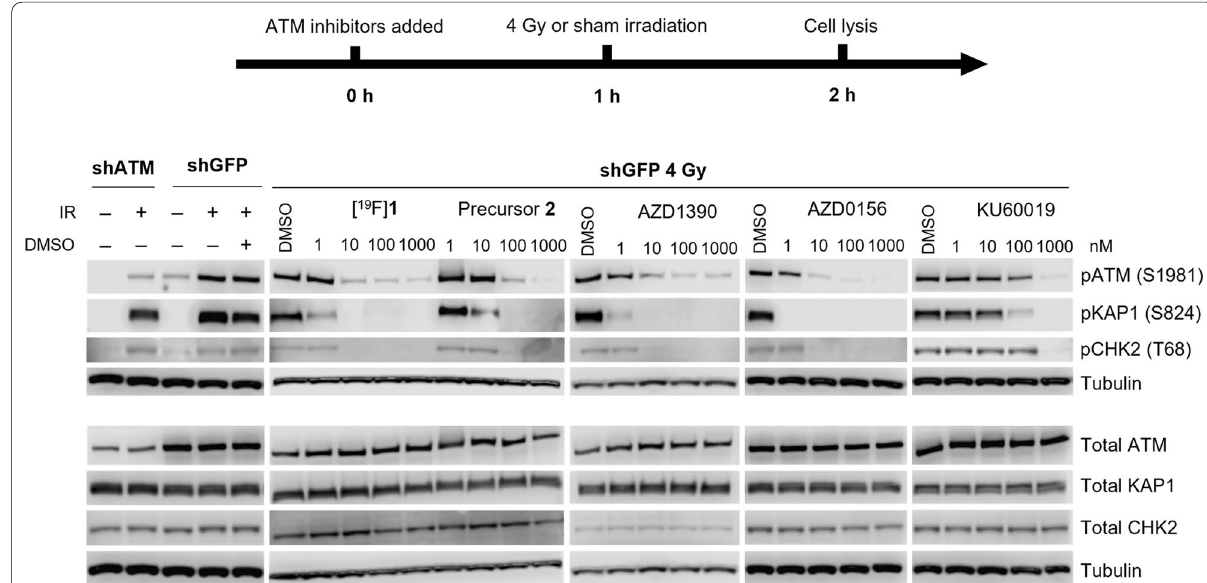
Fig. 3 Higher ATM expression is observed in H1299 shGFP knockdown cells compared to H1299 shATM knockdowns. Irradiation of cells (4 Gy) causes an increased expression of pATM, pKAP1, and pCHK2. A decrease in expression of pATM and downstream targets pKAP1 and pCHK2 is observed following treatment of shGFP (4 Gy) cells with different ATM